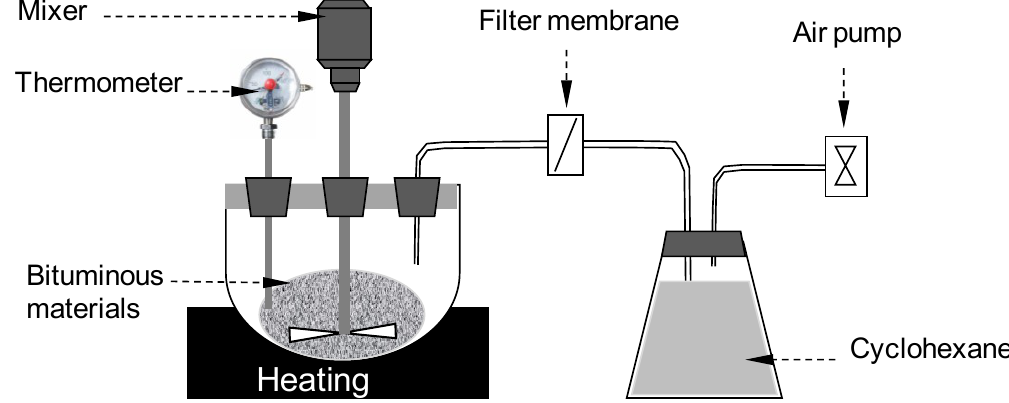
Figure 3. VOC generating and collecting device for the ultraviolet-visible spectroscopy test (UV-Vis)